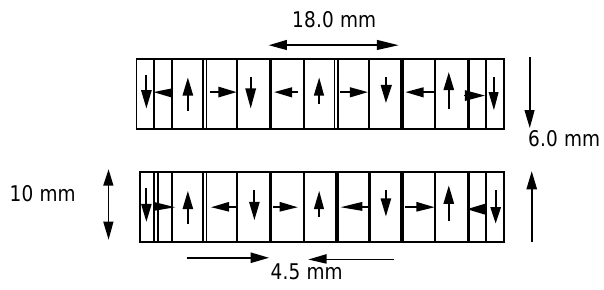
FIG. 1. Schematic side view of two periods of the VISA undu- lator structure, showing a symmetric two-half-block termination scheme. Arrows within the magnet blocks indicate the direction of